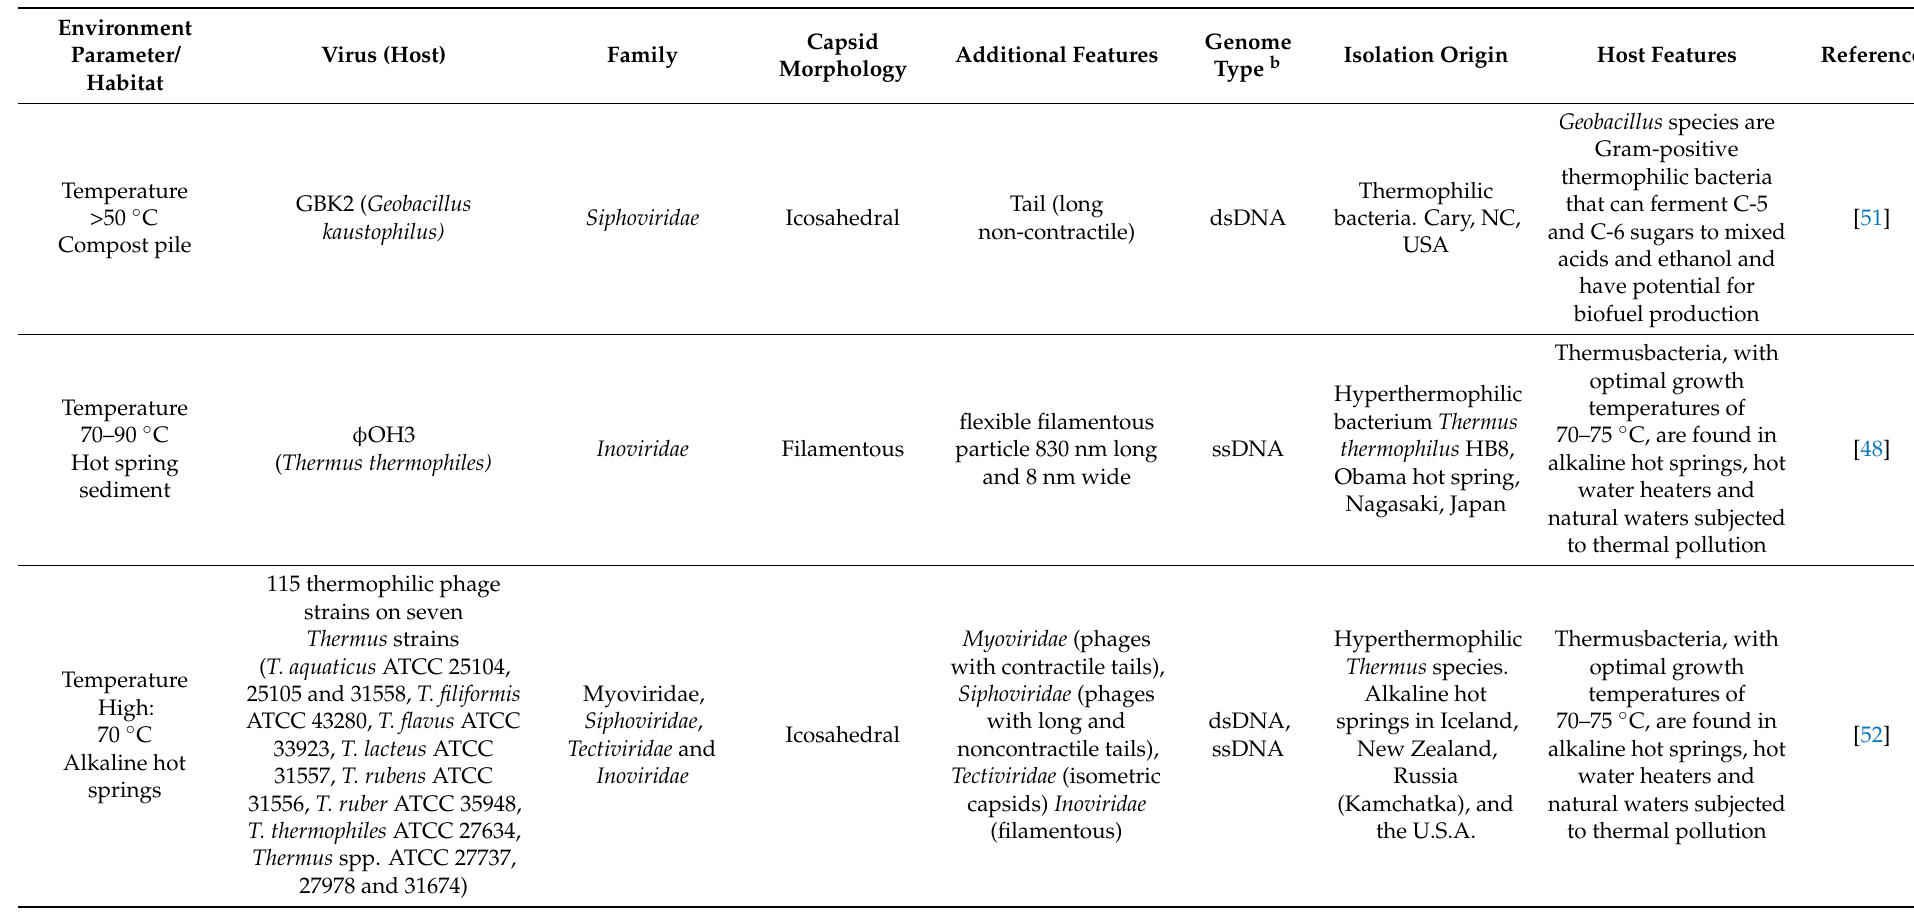
Table 2. Main features of the bacterial viruses characterized in extreme